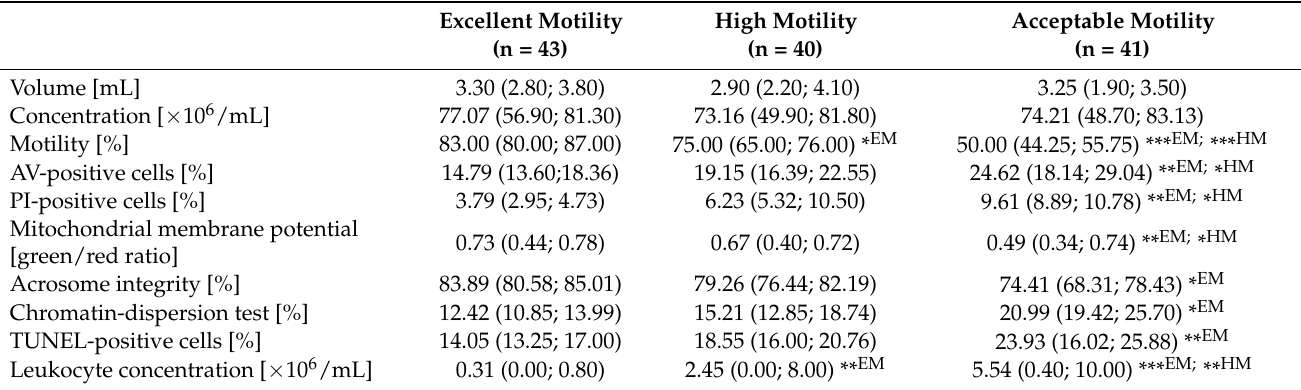
Table 1. Semen quality of the studied